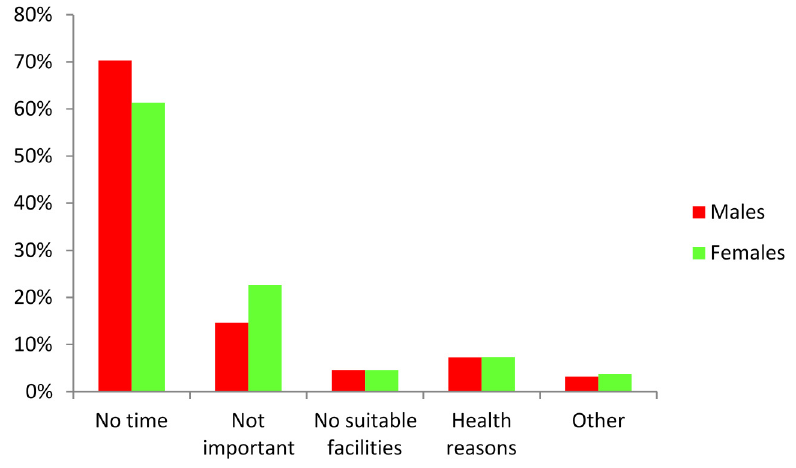
Figure 4. Main barriers to regular participation in physical activity or